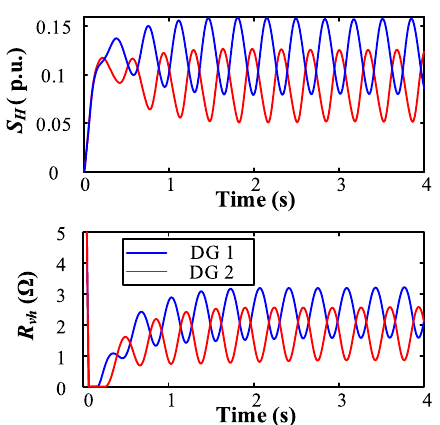
Fig. 16 Oscillations of DGs’ virtual impedance and harmonic power